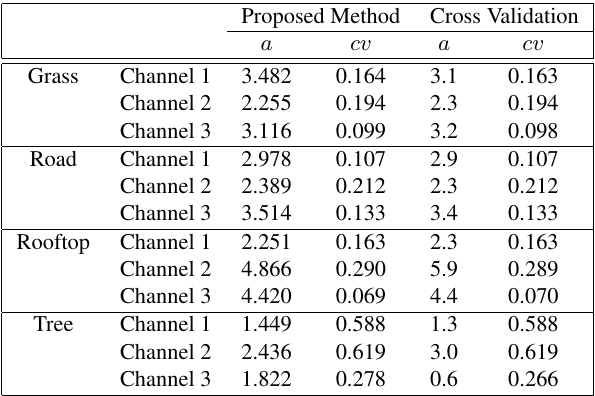
Table 1. A comparison between the estimated a value by the proposed and the cross